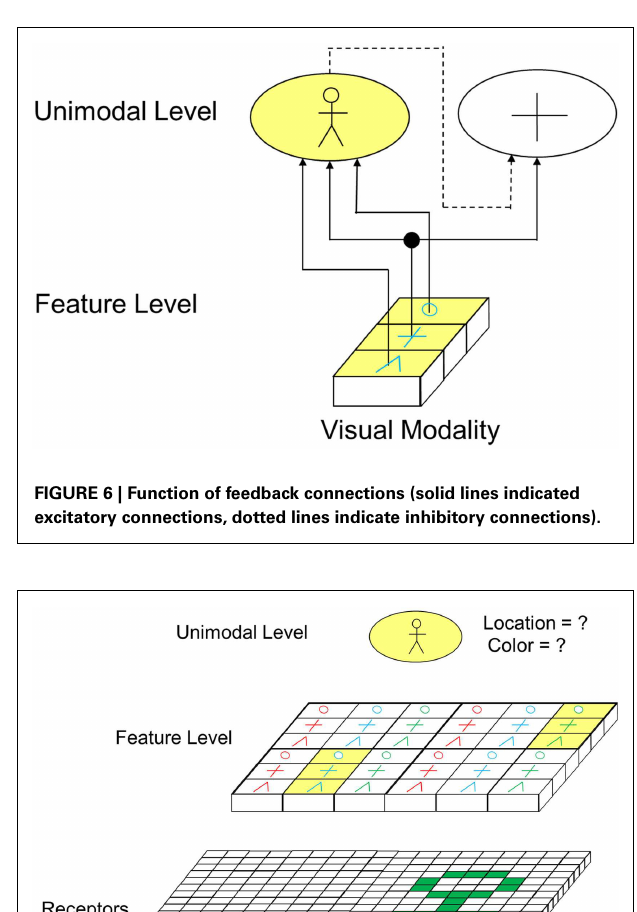
the details) of the person symbol can be obtained. To resolve